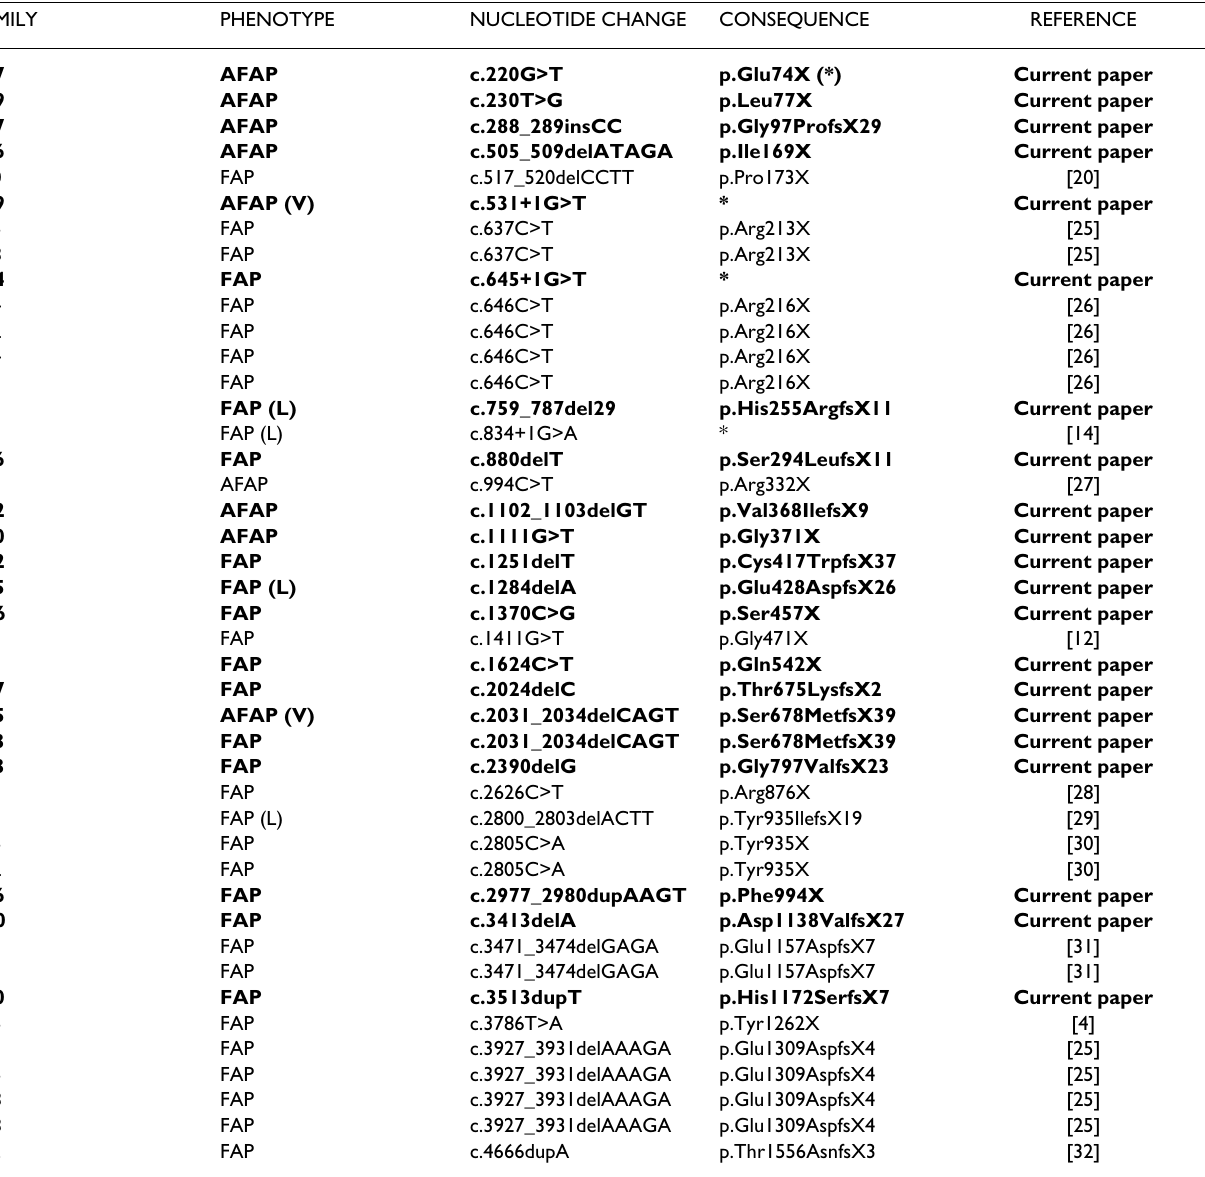
Table 1: APC germline mutations in Czech and Slovak FAP patients FAMILY